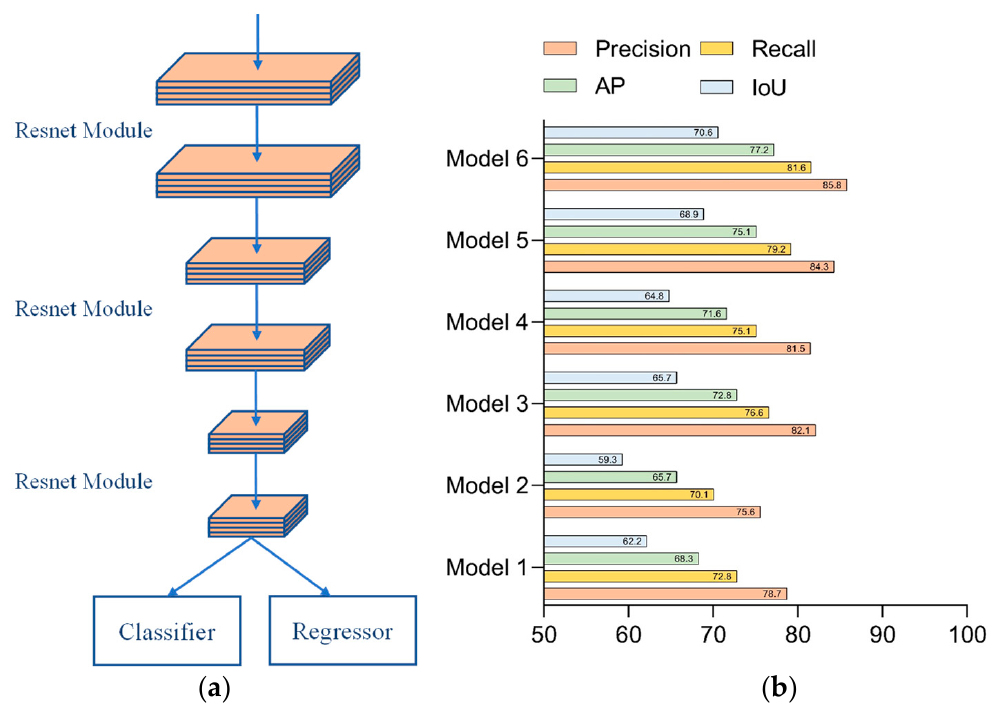
Figure 8. Network 1: ( a ) configuration of Network 1 and ( b ) test results for each parameter of Network 1.